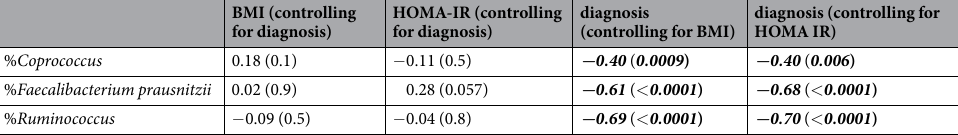
Table 4. Partial Spearman correlation coefficients (p-value); diagnosis was treated as ordinal variable (1-healthy control, 2-simple steatosis, 3-nonalcoholic steatohepatitis). HOMA-IR: homeostasis model assessment estimated insulin